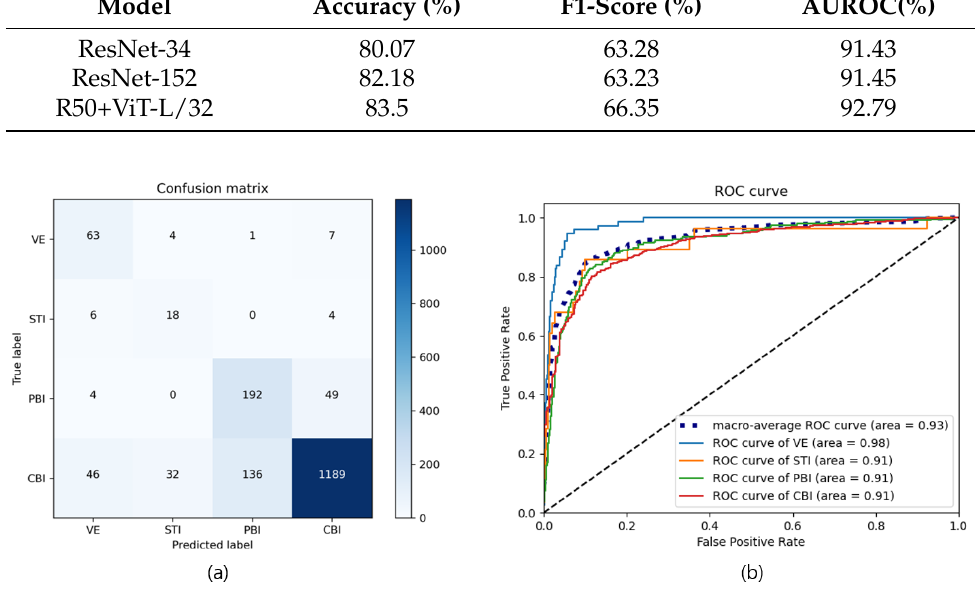
Figure 7. ( a ) The confusion matrix for the extraction difficulty classification, ( b ) the ROC curve for the extraction difficulty classification.